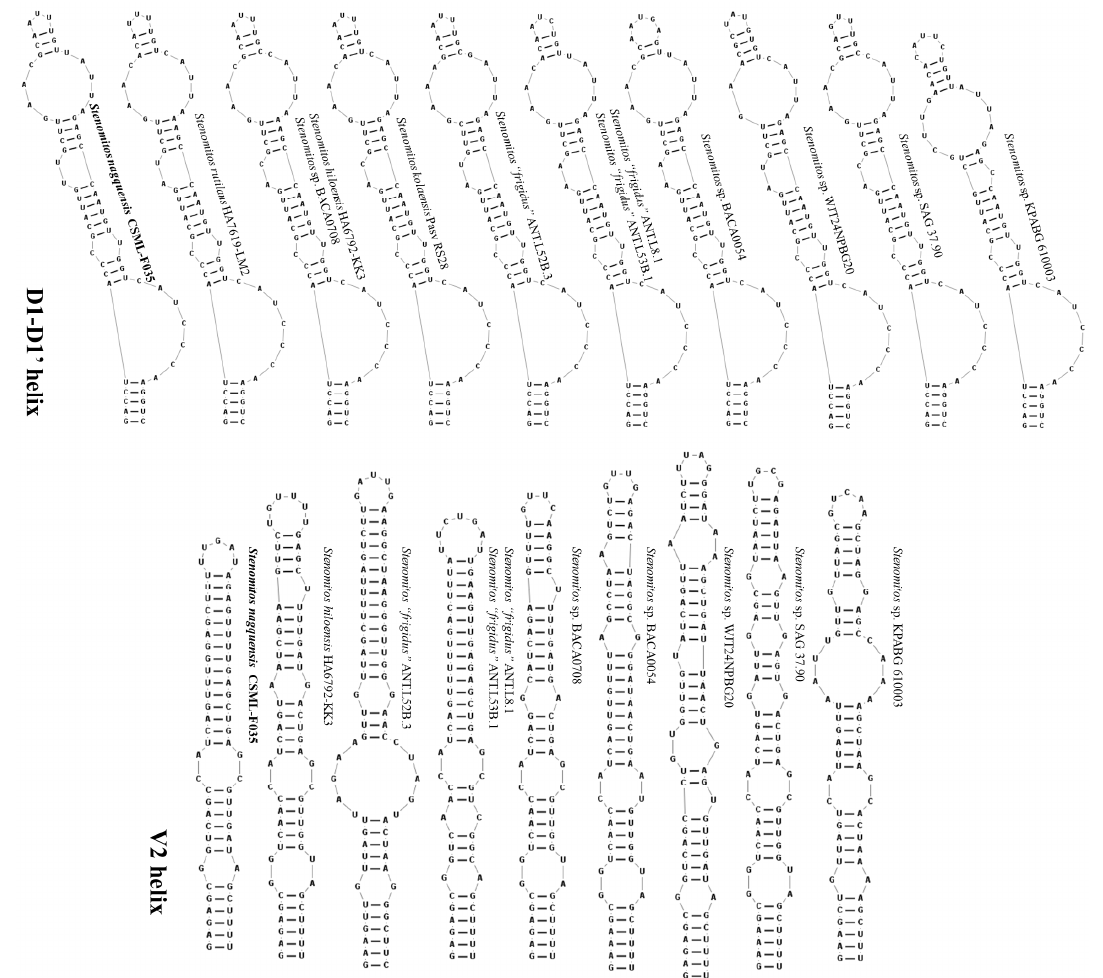
Figure 6. Predicted secondary structures of the D1–D1 ′ and V2 helices of the 16S–23S ITS region of strains of Stenomitos . The novel strain is labelled in bold.